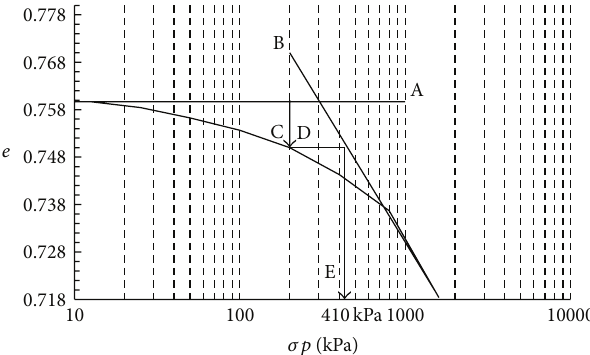
Figure 1: The Pacheco & Silva method to obtain the preconsolida- tion stress.